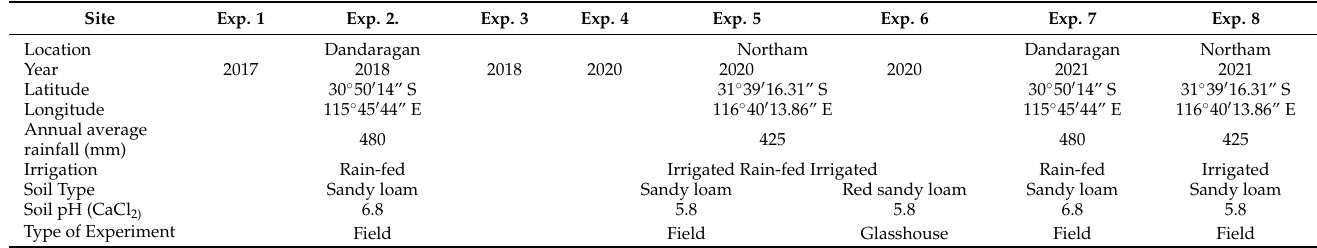
Table 2. General experiment details for eight tedera herbicide tolerance experiments.